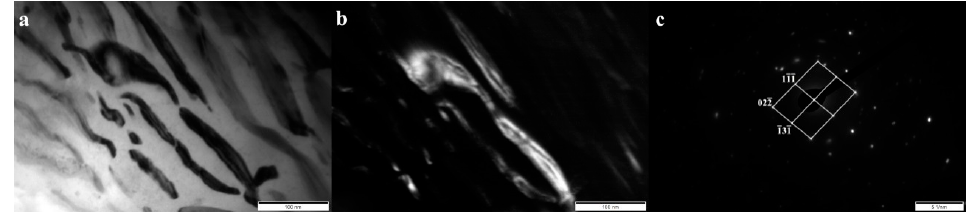
Figure 8. ( a ) Bright field image of eutectic ( γ + M 7 C 3 ) in layer III. ( b ) Dark field image obtained from reflection (1-1-1) from the eutectic M 7 C 3 carbide—shown in ( c ). ( c ) Selected area diffraction pattern (SAED) of the area shown in ( a ), along with the solution. Eutectic carbide M 7 C 3 [211] was found. Transmission electron microscope, 150 kV.